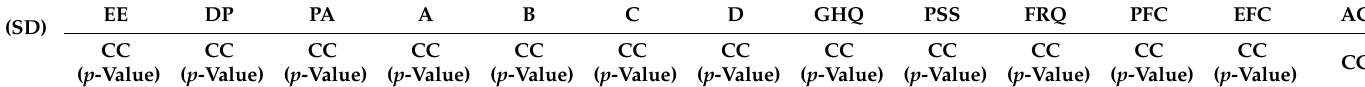
Table 2. Relationship between burnout, perceived stress, job satisfaction, coping strategies, and general